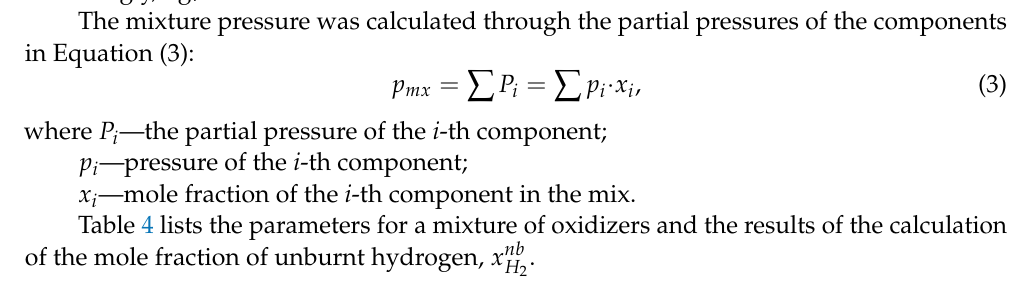
Table 4. Basic parameters for the calculation and obtained mole fraction of unburnt hydrogen. Dilution Degree,